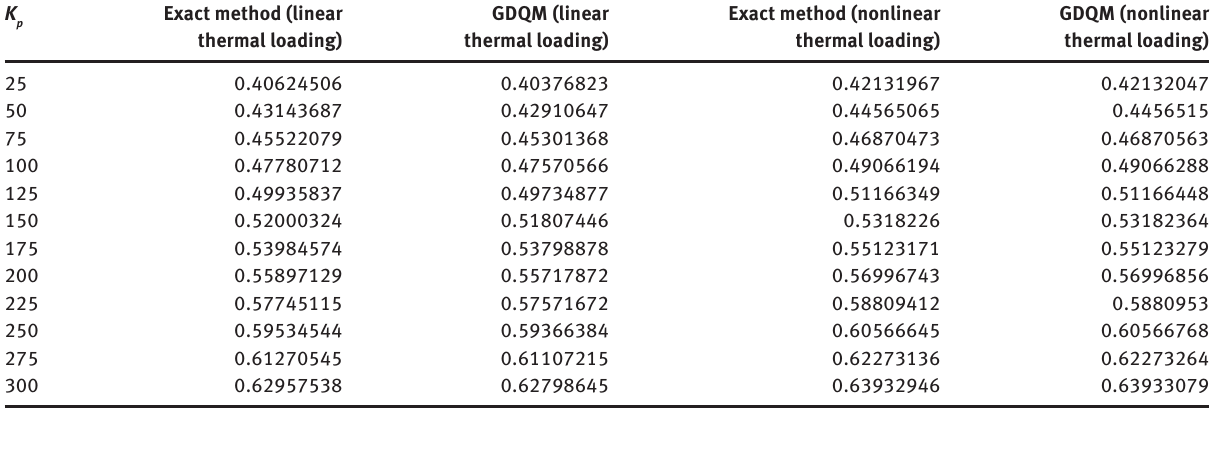
Table 3: Comparison the results of GDQM and exact method for both linear and nonlinear thermal loadings in different Pasternak stiffness.